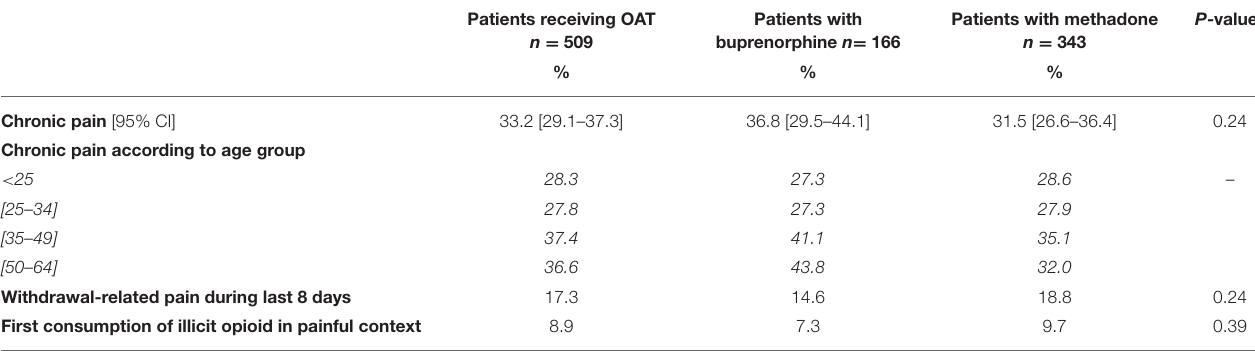
TABLE 2 | Prevalence of chronic pain in patients receiving OAT.